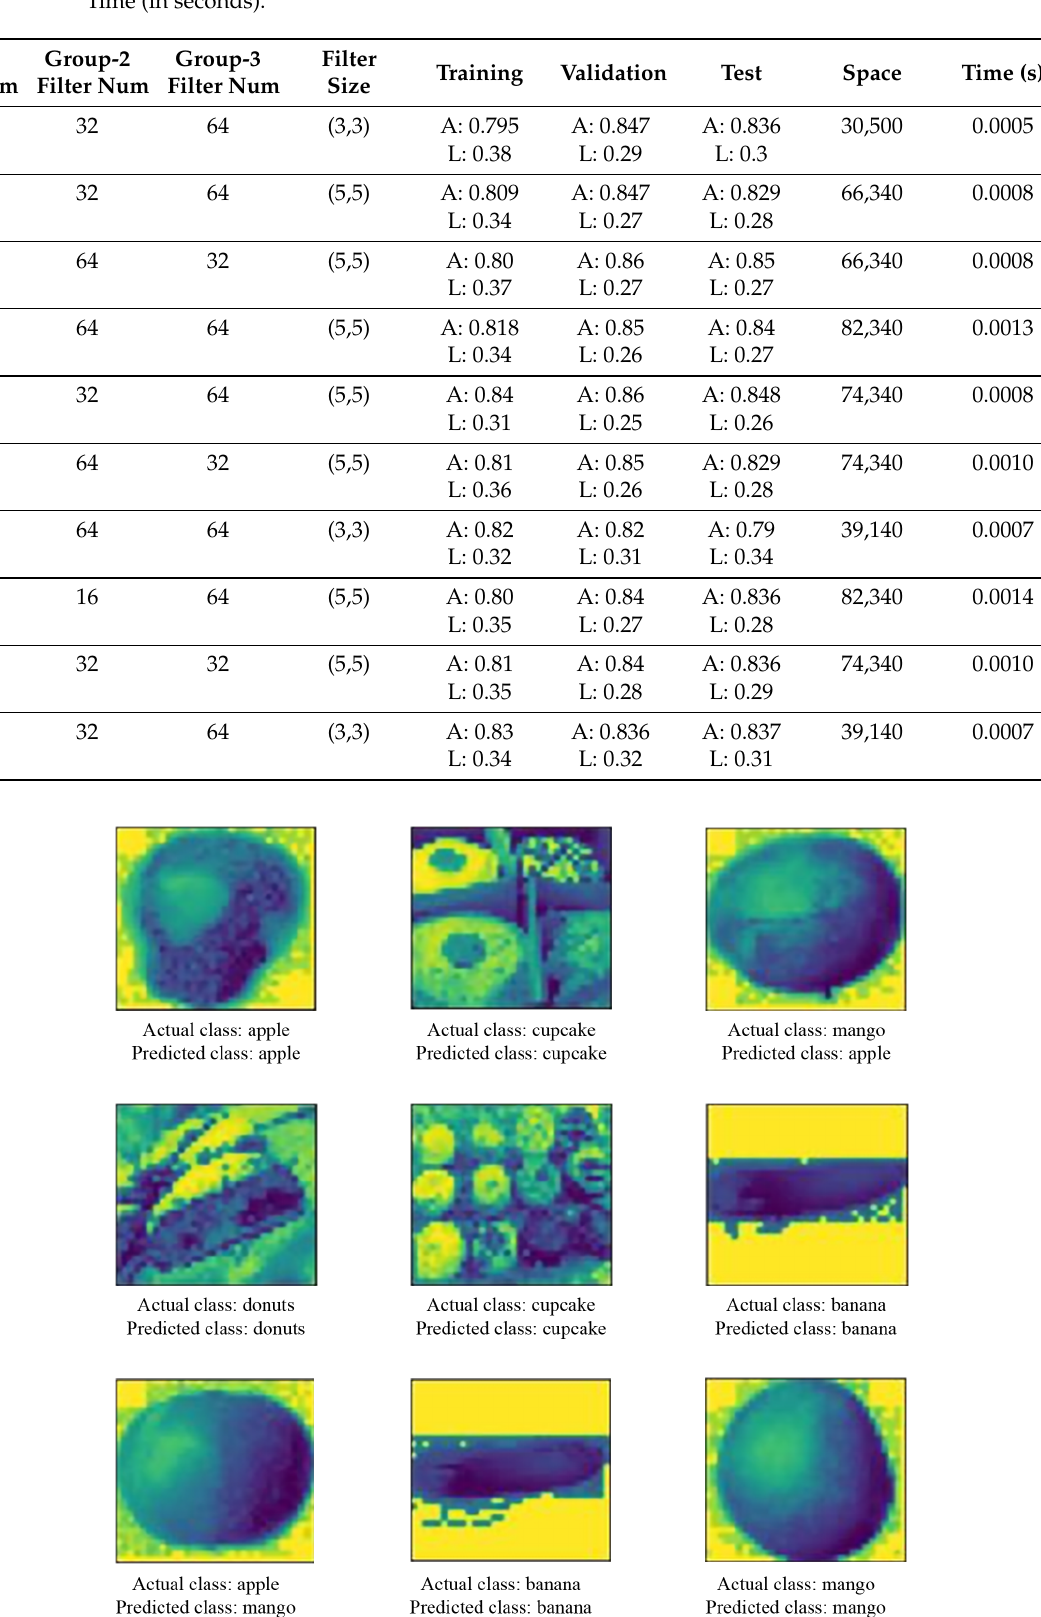
Figure 4. Real-time food image recognition using model